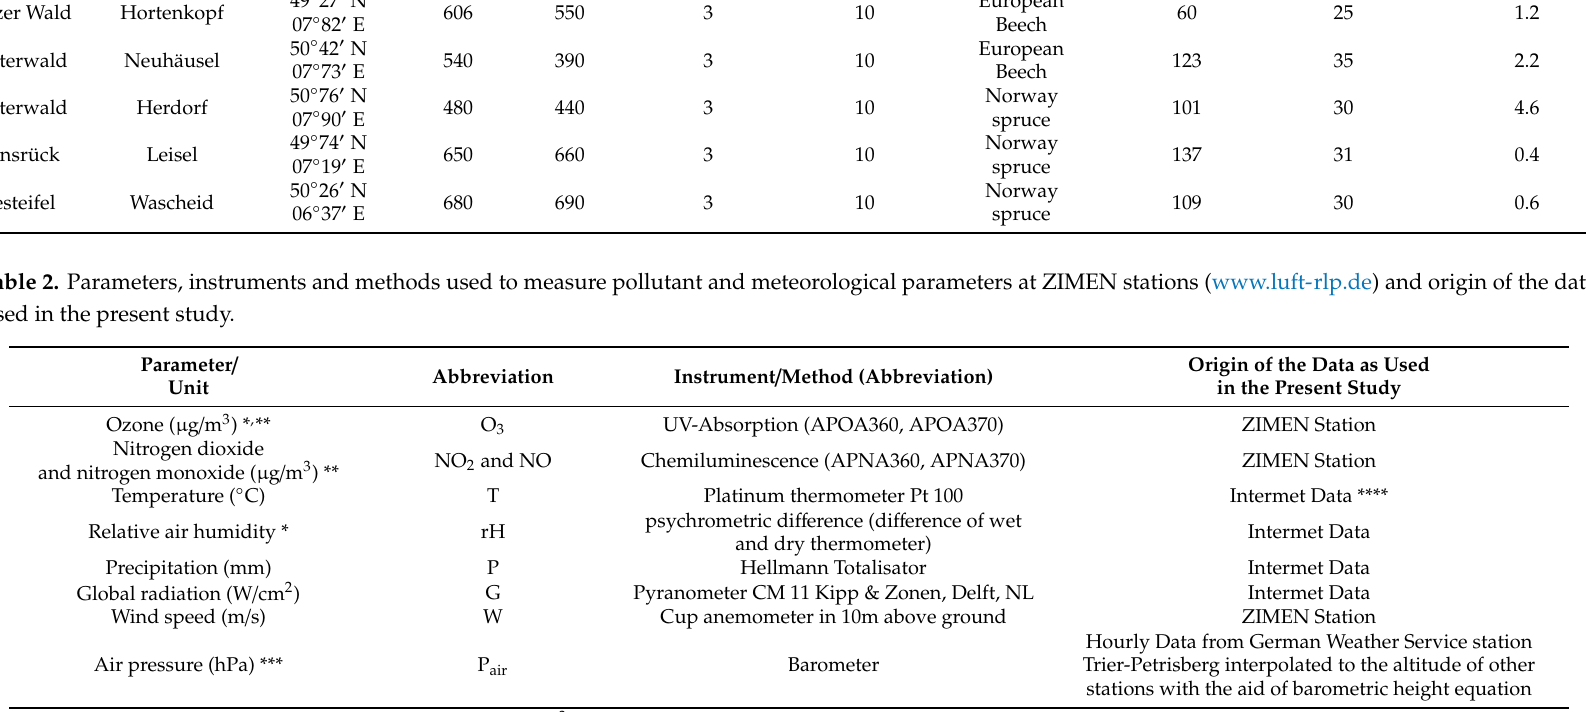
Hourly Data from German Weather Service station Trier-Petrisberg interpolated to the altitude of other stations with the aid of barometric height